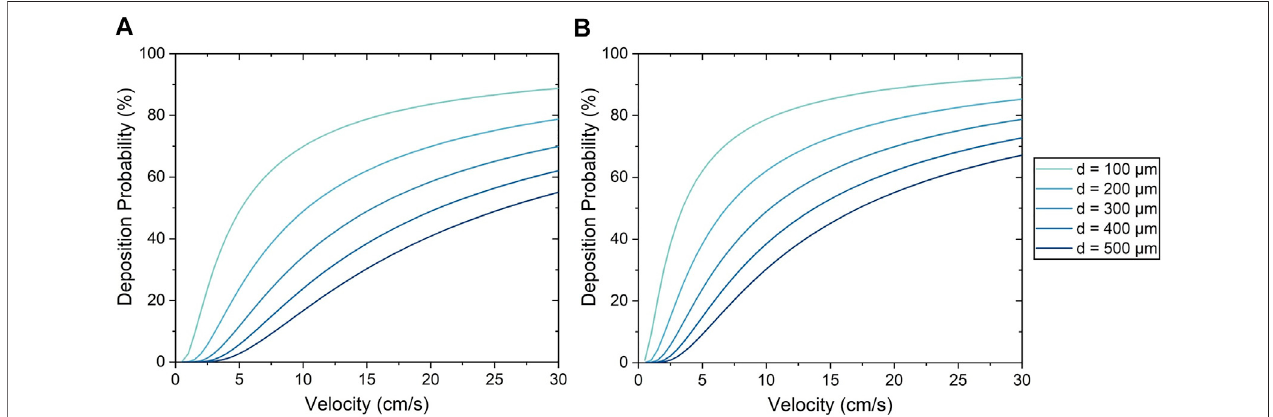
FIGURE 8 | Cell deposition probability using the Stokes algorithm with an inertia coef fi cient of (A) C = 200 and (B) C = 300.